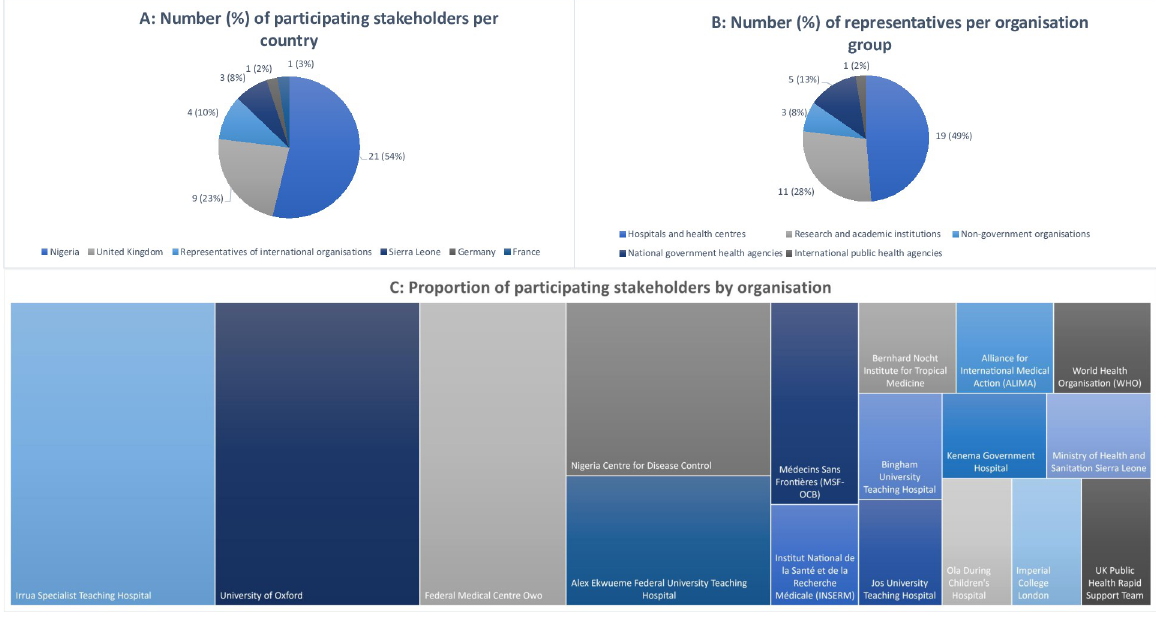
Fig 2. Participating stakeholder